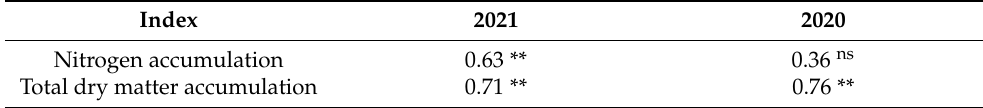
Table 6. Correlation analysis between grain yield and nitrogen and dry matter accumulation.